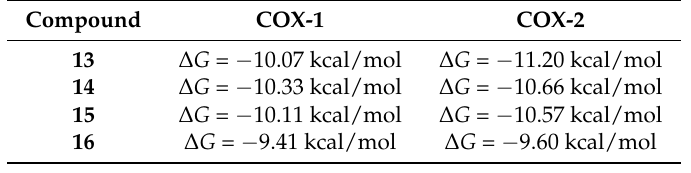
Table 2. Docking study results of synthesized compounds.